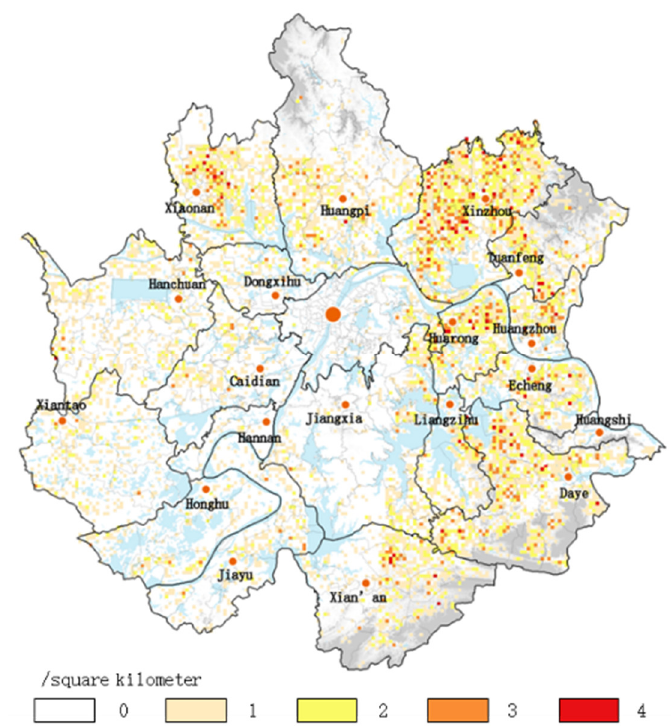
Figure 6. Analysis of rural settlement density in the Wuhan metropolitan area.